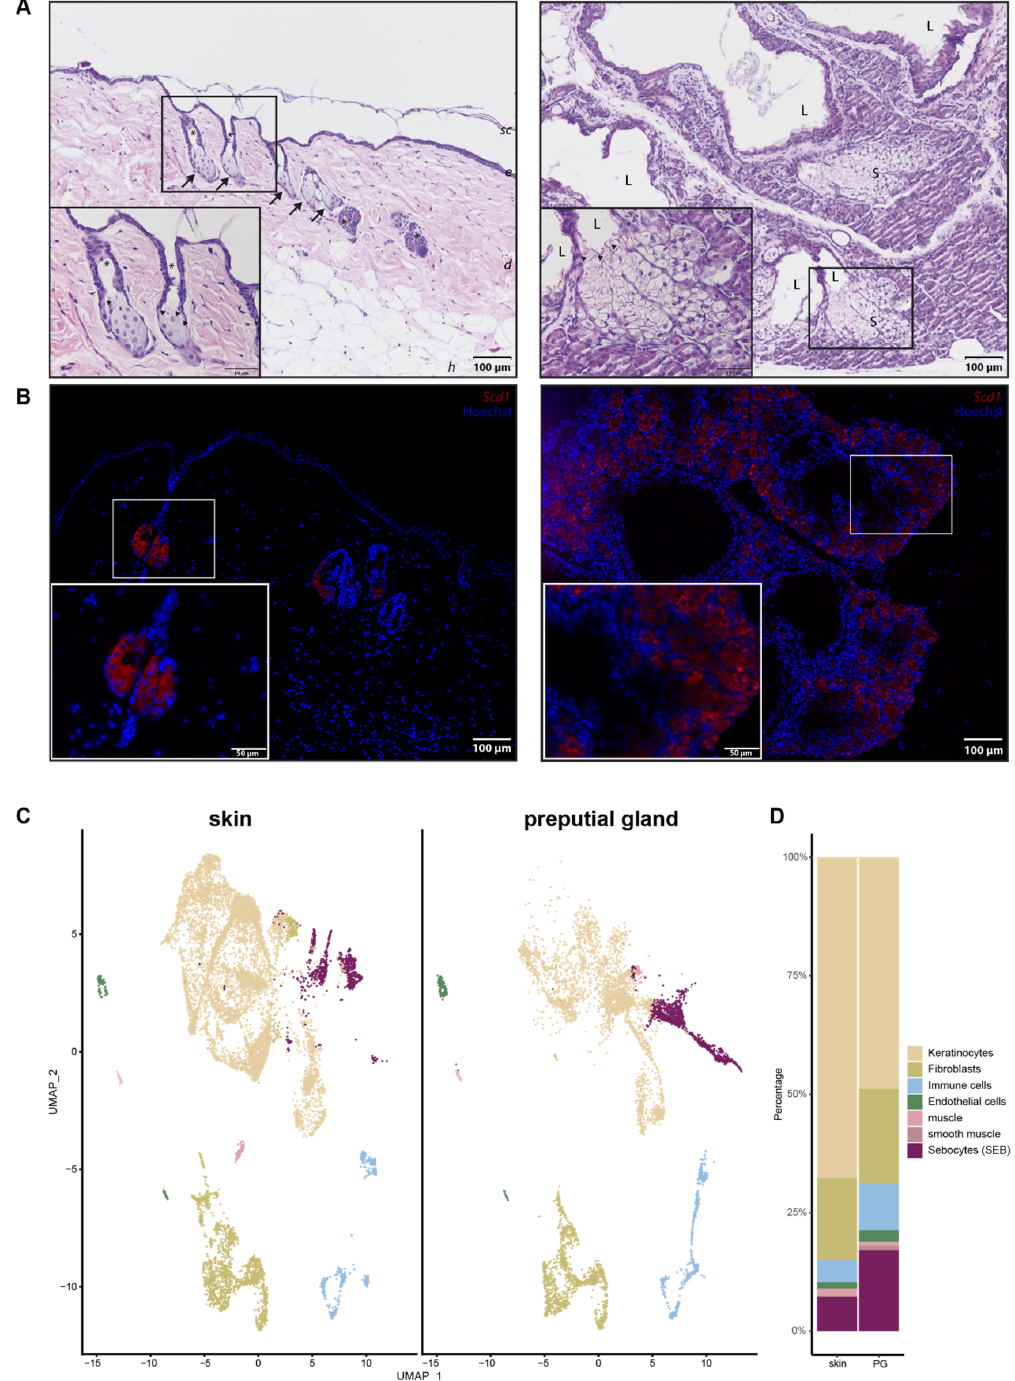
Figure 1. Comparison of skin and preputial gland sebocytes. ( A ) Hematoxylin and eosin staining of a skin biopsy (left panel) and a preputial gland (right panel). Arrows indicate sebaceous glands in close proximity to hair shafts marked by asterisks. Arrowheads indicate differentiated sebocytes with degenerated nuclei, facing the lumen of either the hair shaft or the lumen of the preputial gland; Scale bar = 100 µm, 50 µm in insert; sc: stratum corneum; e: epidermis; d: dermis; h: hypodermis; L: lumen of the preputial gland; S: sebocytes; ( B ) Representative immunofluorescence labeling of Scd1 + sebocytes in the skin (left panel) and the preputial gland (right panel); scale bar = 100 µm, 50 µm in insert. Tissues of n = 3, respectively. ( C ) UMAP-plots comparing cells of skin biopsies ( n = 3) and preputial glands ( n = 3), split by tissue, identifying keratinocytes, fibroblasts, immune cells, endothelial cells, muscle and smooth muscle cells and sebocytes (SEB). ( D ) Bar plot indicating relative numbers of cell populations identified within the skin and preputial gland.